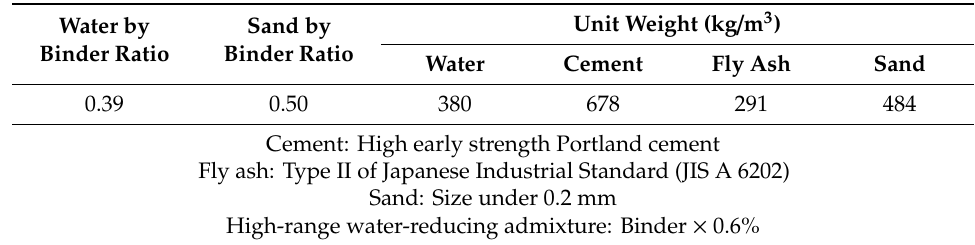
Table 2. Mixture proportion.